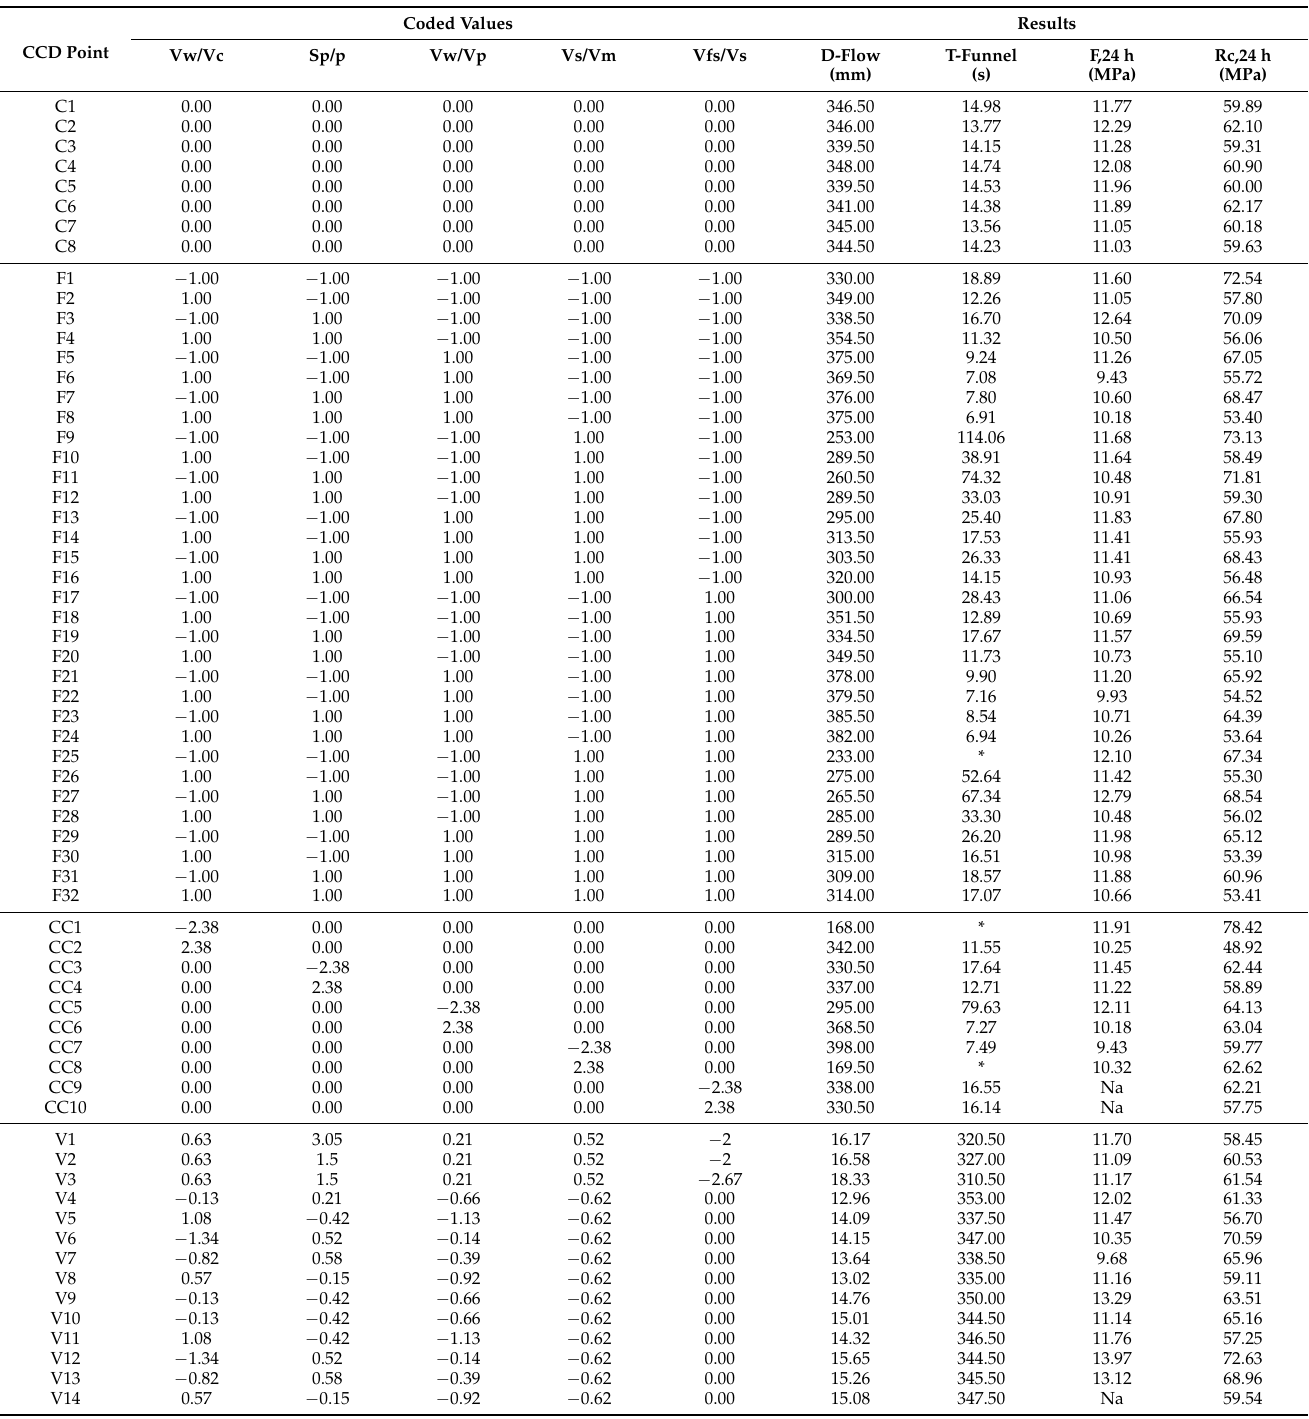
Table 3. The mixture proportion (coded values) and experimental results obtained by Maia [25] and used for model fitting and validation